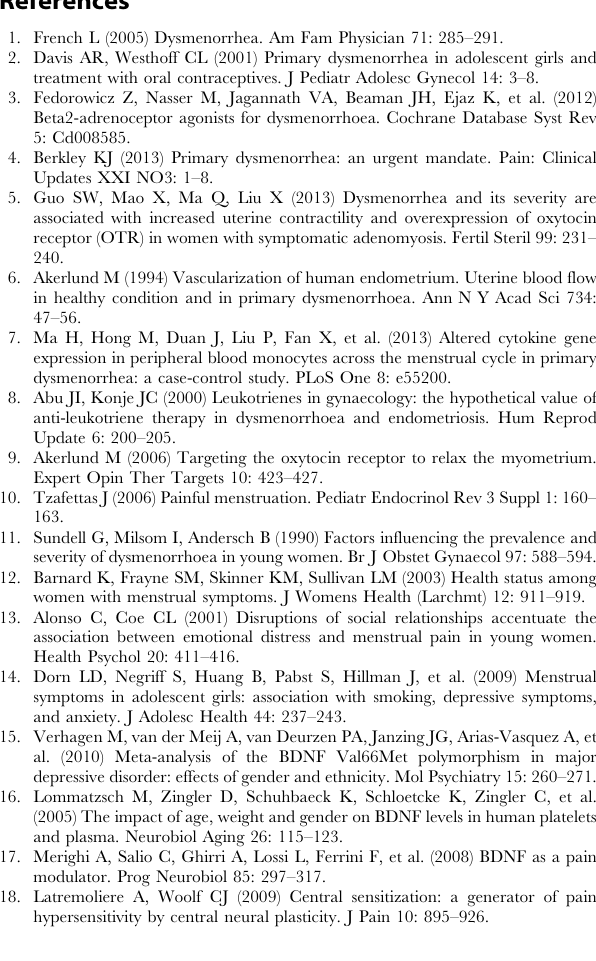
Table S1 BDNF rs6265 genotype distributions and allele frequency in the behavioral/hormonal sub-groups.